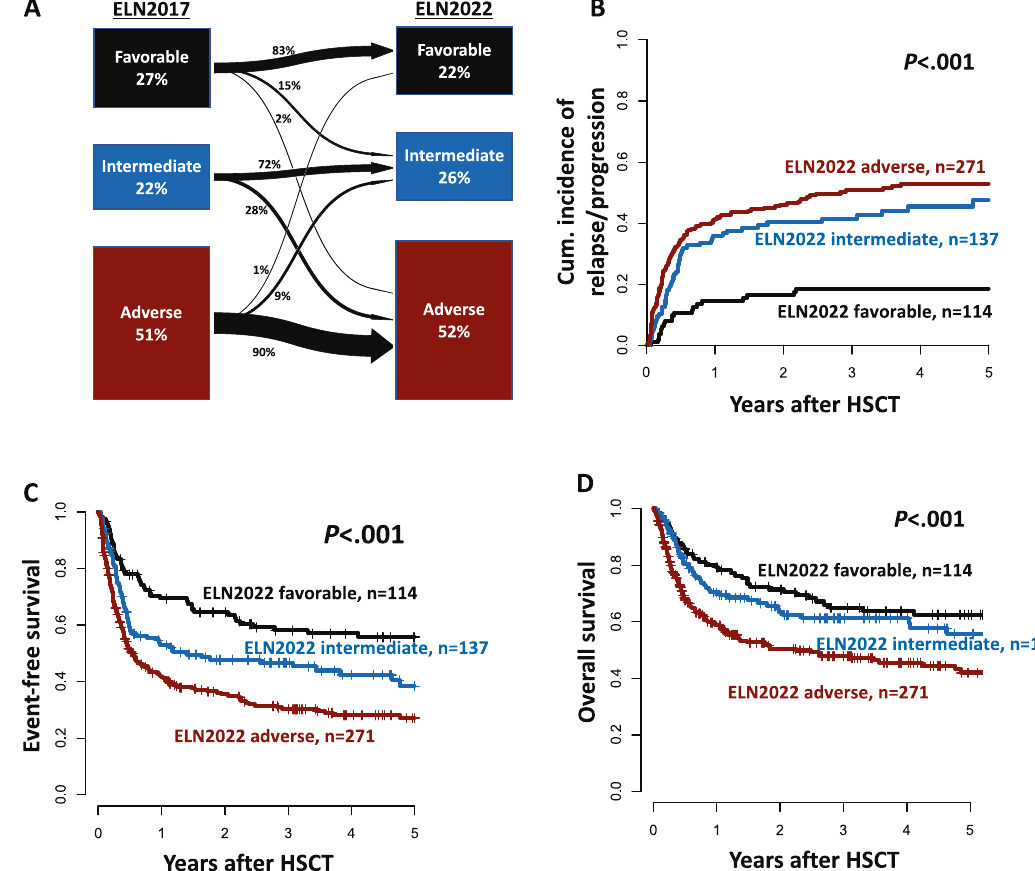
Fig. 1 Risk distribution and outcomes according to the ELN2022 genetic risk groups at diagnosis. A Transition plot of risk distribution between the ELN2017 and ELN2022 risk strati fi cation systems at diagnosis. B Cumulative incidence of relapse, C Event-free survival, and D Overall survival according to the ELN2022 genetic risk groups in the whole patient cohort ( n =